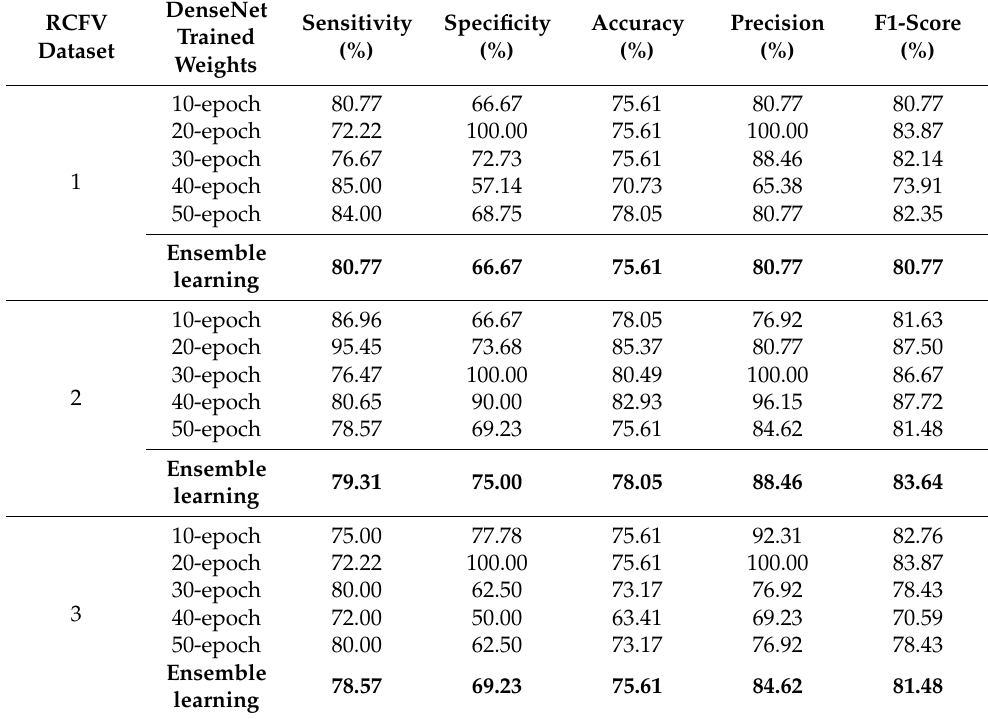
Table 8. DenseNet performances of specified weights with ensemble